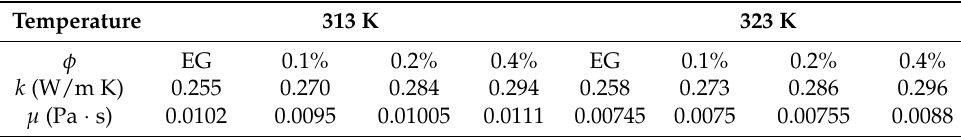
Table 8. Nanofluid thermophysical properties [57].